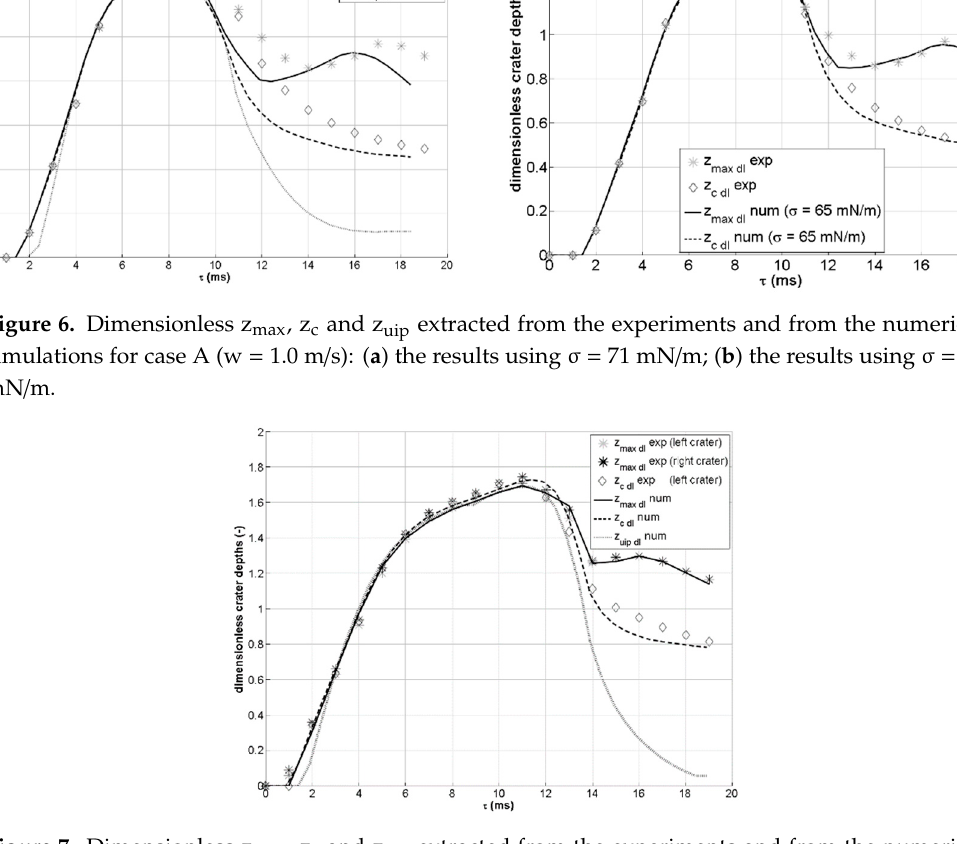
Figure 7. Dimensionless z max , z c and z uip extracted from the experiments and from the numerical simulations for case B (w = 1.4 m/s). volume-of-fluid (VOF) results using σ = 71 mN/m.